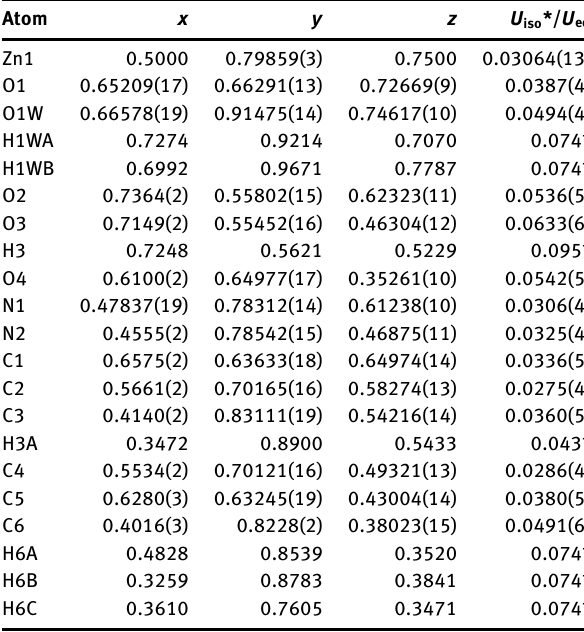
Table 2: Fractional atomic coordinates and isotropic or equivalent isotropic displacement parameters (Å 2